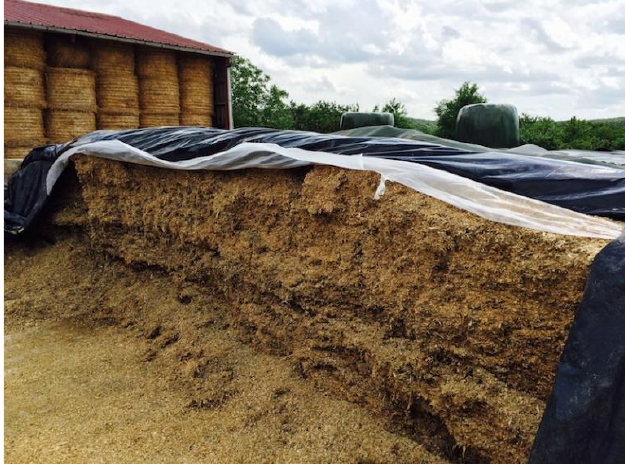
Figure 18. Protection Silage films. Reprinted from website [46].